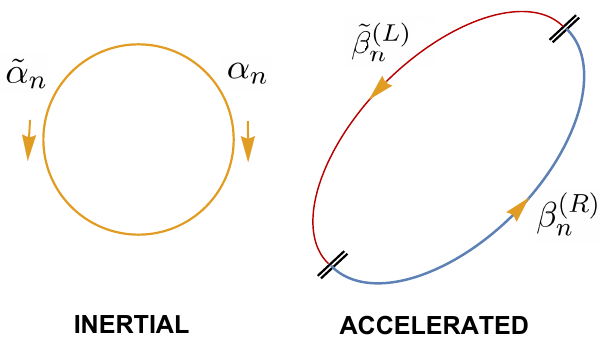
Figure 7 . Illustration of temporal cross sections for inertial and accelerated worldsheets. The arrows indicate flow of timelike killing fields. Accelerated string is “divided” into two segments due to worldsheet discontinuities, but continues to “live” simultaneously in both